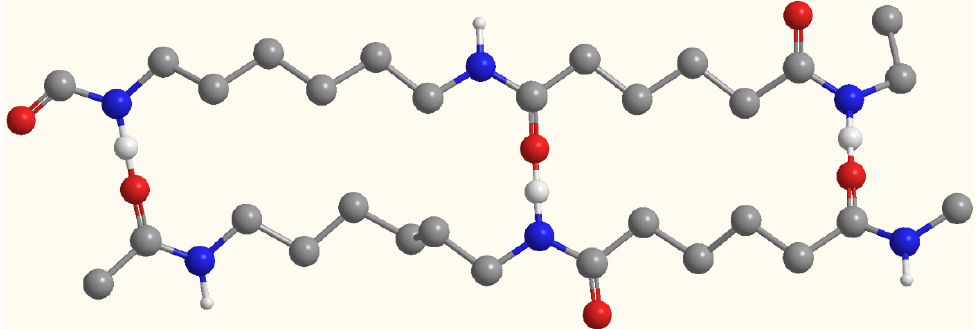
Figure 3. Hydrogen bond arrangement of polyamide 66.